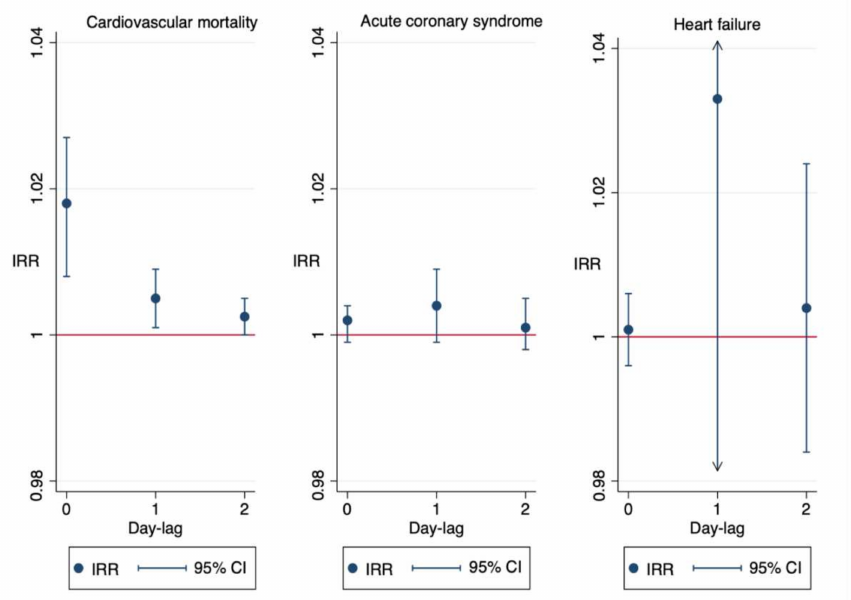
Figure 4. Meta-analyses performed for each objective and for each lag day from the day of exposure to desert dust until a lag of 2 days (lag 0, lag 1, and lag